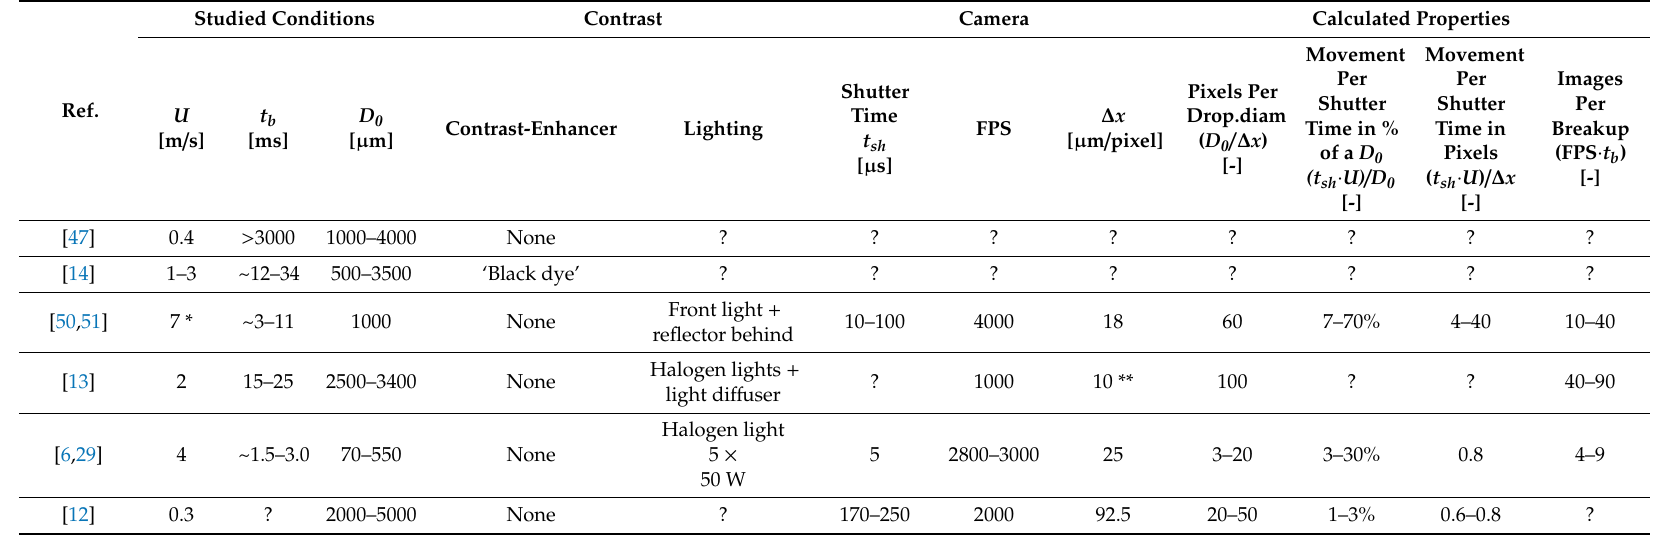
Table 2. Setup and optical considerations presented in previously reported single drop breakup visualization studies. For each of the studies, the specified experimental conditions, the steps taken to ensure a su ffi cient contrast in visualization images, and the high-speed camera settings are shown, together with four calculated properties added as suggestions of relevant guidelines for future investigations (see Section 4.4 for a discussion).